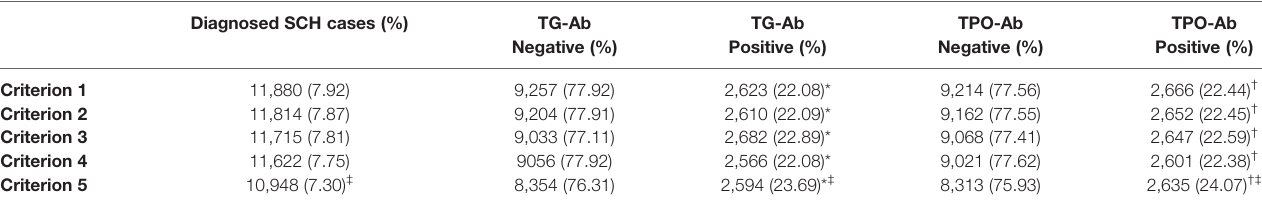
TABLE 2 | The different criteria for diagnosing SCH based on TSH concentrations of ≥ 4.5 mIU/L. Diagnosed SCH cases